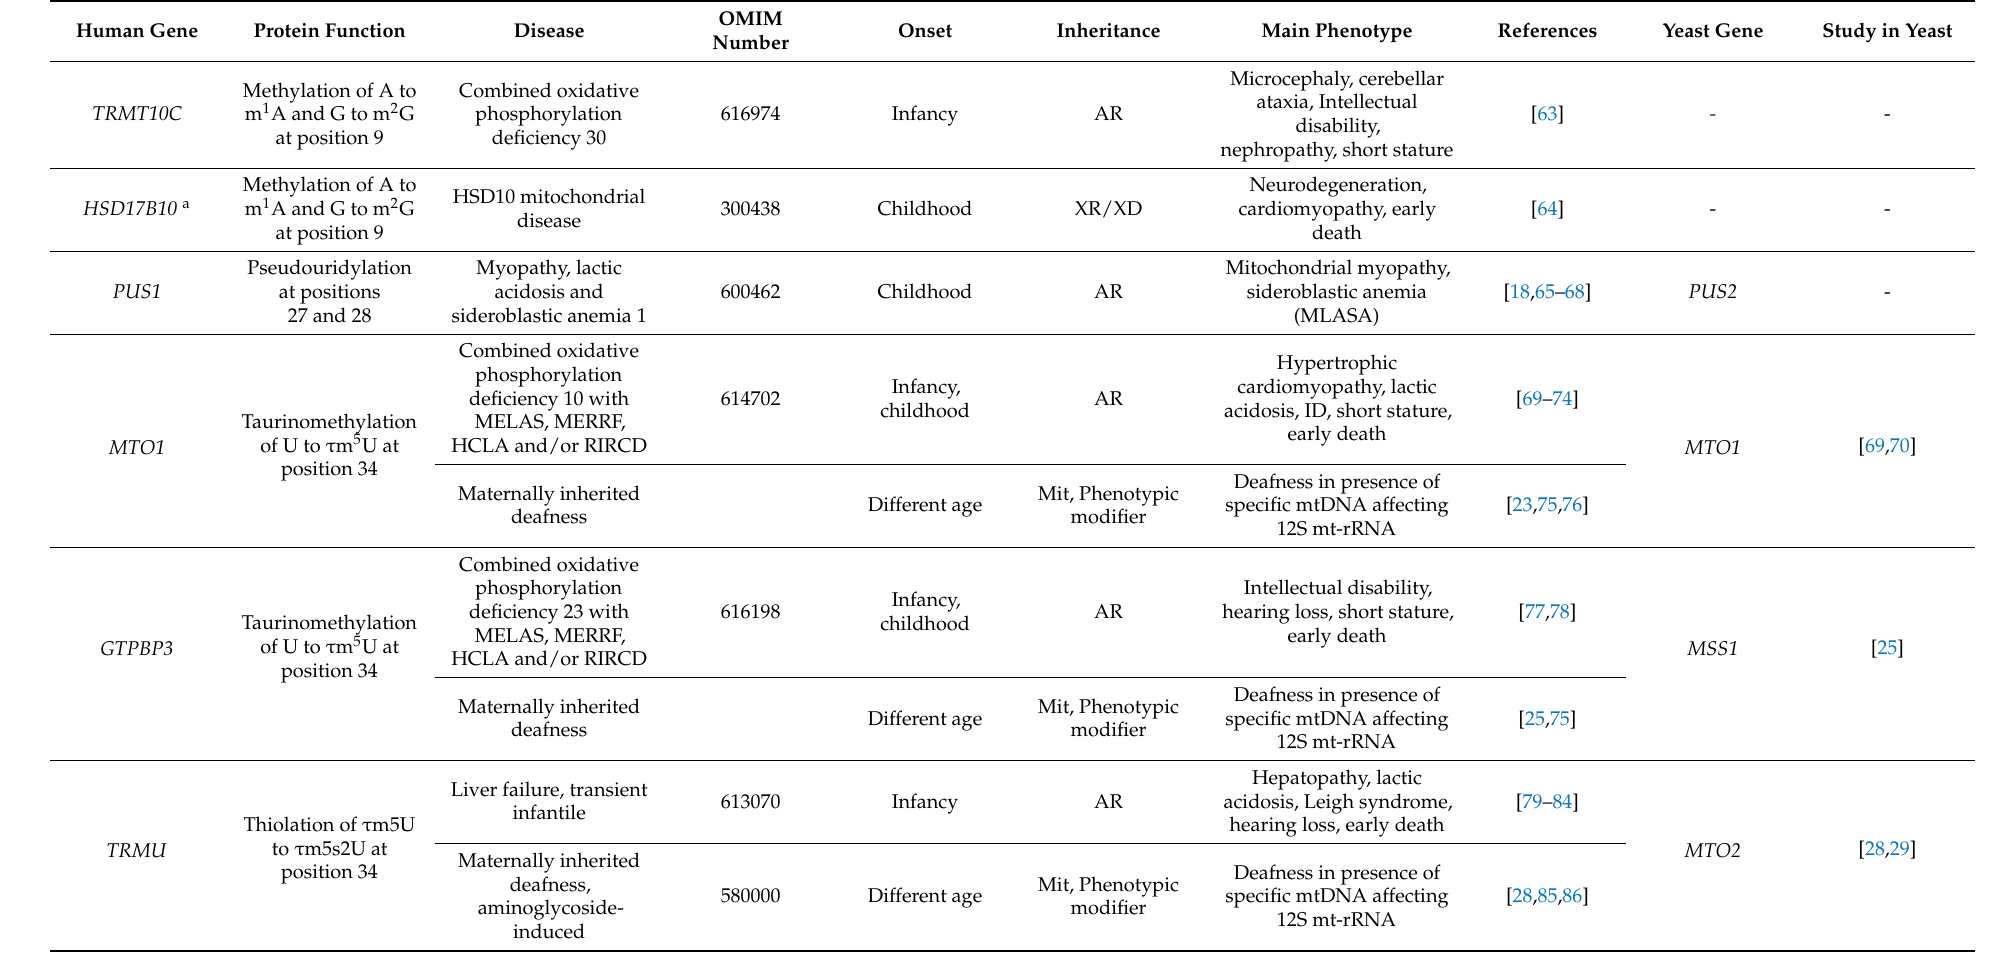
Table 2. Genes encoding for mt-tRNA modifying enzymes associated with mitochondrial diseases. Yeast studies are reported only if yeast was used to confirm the pathogenicity of the mutations found in patients, or in general for studying mutations affecting the efficiency of modification. Abbreviations: HCLA: hypertrophic cardiomyopathy and lactic acidosis; MELAS: mitochondrial encephalomyopathy, lactic acidosis and stroke-like episodes; MERRF: myoclonic epilepsy with ragged red fibers; HCLA: hypertrophic cardiomyopathy and lactic acidosis; RIRCD: reversible infantile respiratory chain